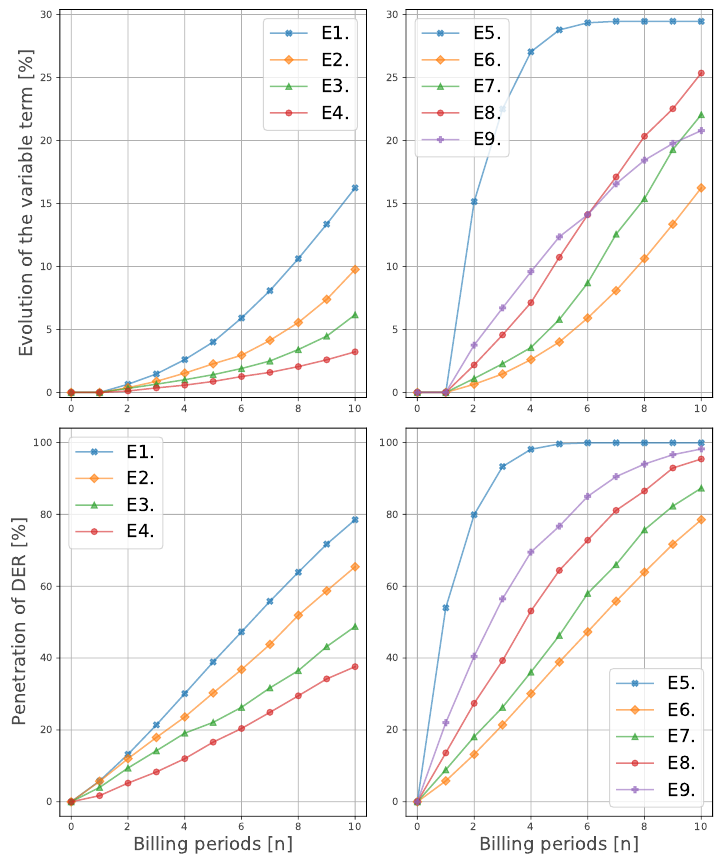
( dis ) Figure 3. Evolution of Π n (upper two figures) and of the DER adoption (lower two figures) across the discrete time dynamical system, for the evaluation of tariff designs E1–E4 (left-hand side figures), and of the incentive mechanisms E5–E9 (right-hand side figures).